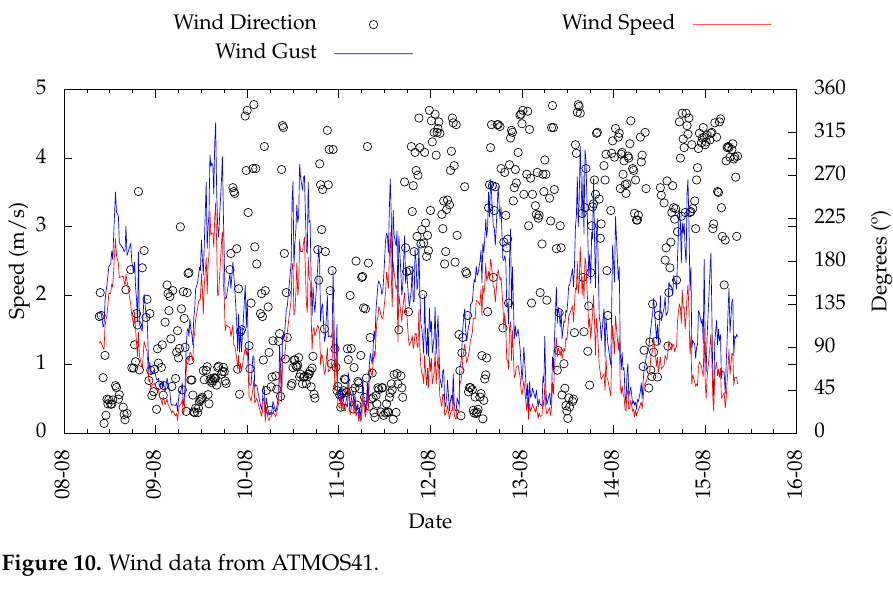
Figure 9. Solar radiation data from ATMOS41.